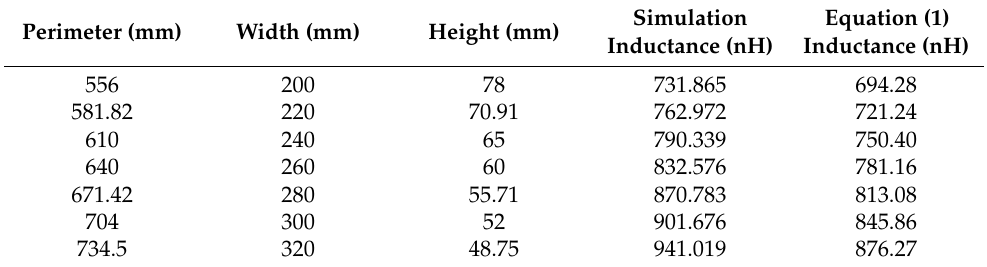
Table 9. Inductance calculation of a single loop rectangle with a constant area (15,600 mm 2 ) using Ansys simulations and Equation (1). Table 10. Inductance calculation of a single loop rectangle with a constant perimeter (640 mm) using Ansys simulations and Equation